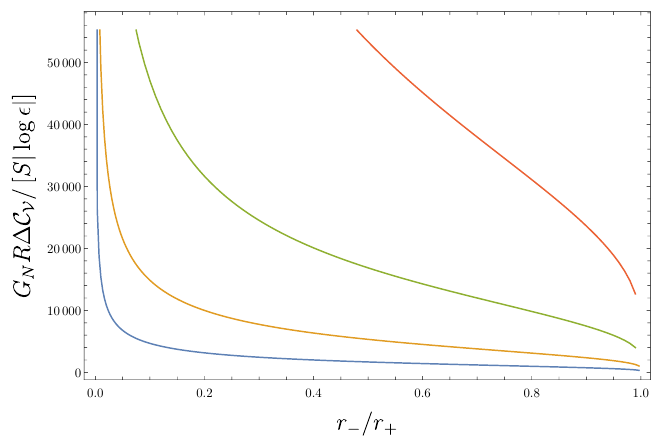
Figure 17. A plot of ∆ C V normalized by the entropy in five dimensions. The graph displays four curves corresponding to r + /‘ = 10 5 , 10 6 , 10 7 , 10 8 . The curves are plotted as a function of (cid:15) = 1 − r − /r + . The value of r + /‘ increases from the blue curve to the red